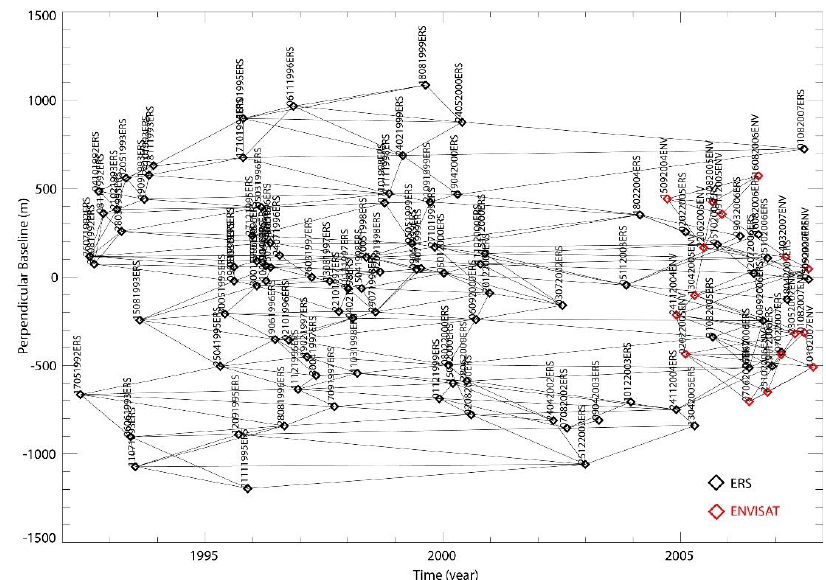
Figure 12. Sketch of the SAR data distribution in the temporal/perpendicular baseline plane. The black and red diamonds represent the ERS and ENVISAT acquisitions, respectively; each arc of the graph corresponds to a generated interferogram.